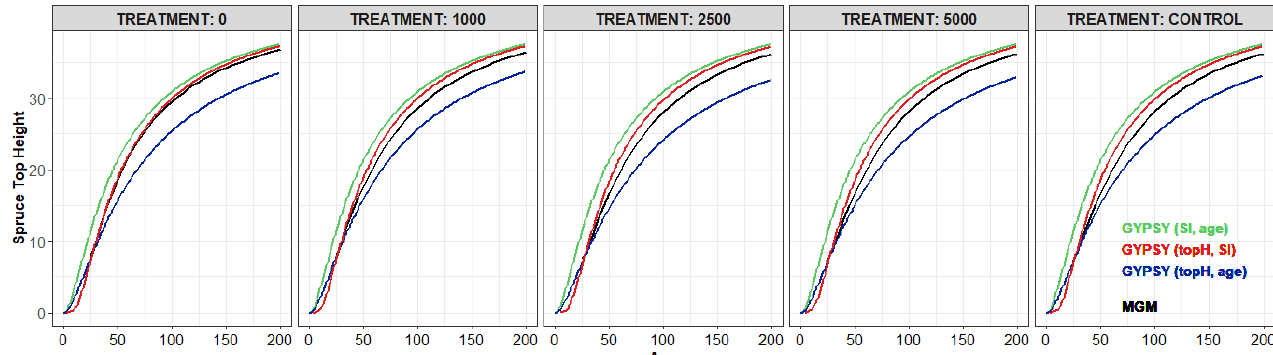
Figure 2. Projected spruce top height trajectories by treatment using different combinations of input attributes. Growth and Yield Projection System (GYPSY) (SI, age) = GYPSY results based on input of site index and age; GYPSY (topH, SI) = GYPSY results based in input of top height and SI; GYPSY (topH, age) = GYPSY results based on input of top height and age; MGM = Mixedwood Growth Model (MGM) results.